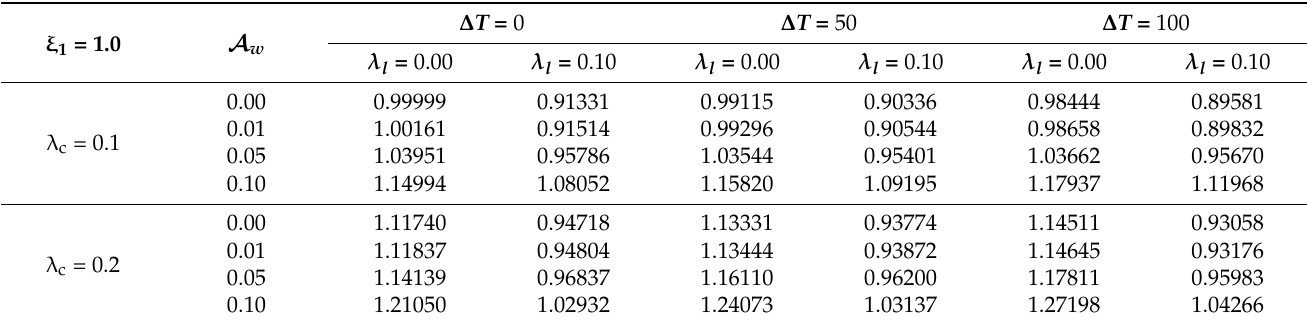
Table 11. Nonlinear dimensionless natural frequencies of porous FG clamped–clamped (C–C) nano- beam for ξ 1 = 1.0 in the case of First-Order Hamiltonian Approach.